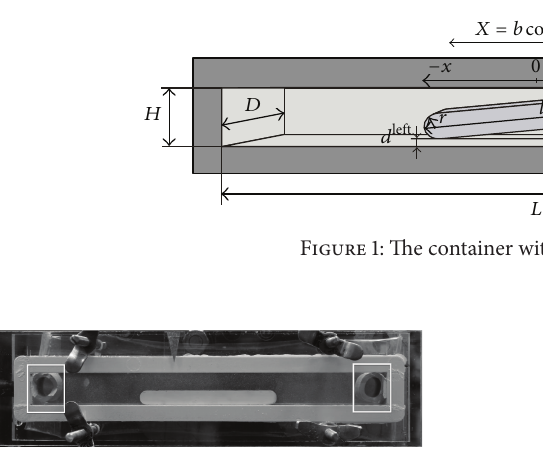
Figure 2: Photo of the container with a body fastened on a vibrator.